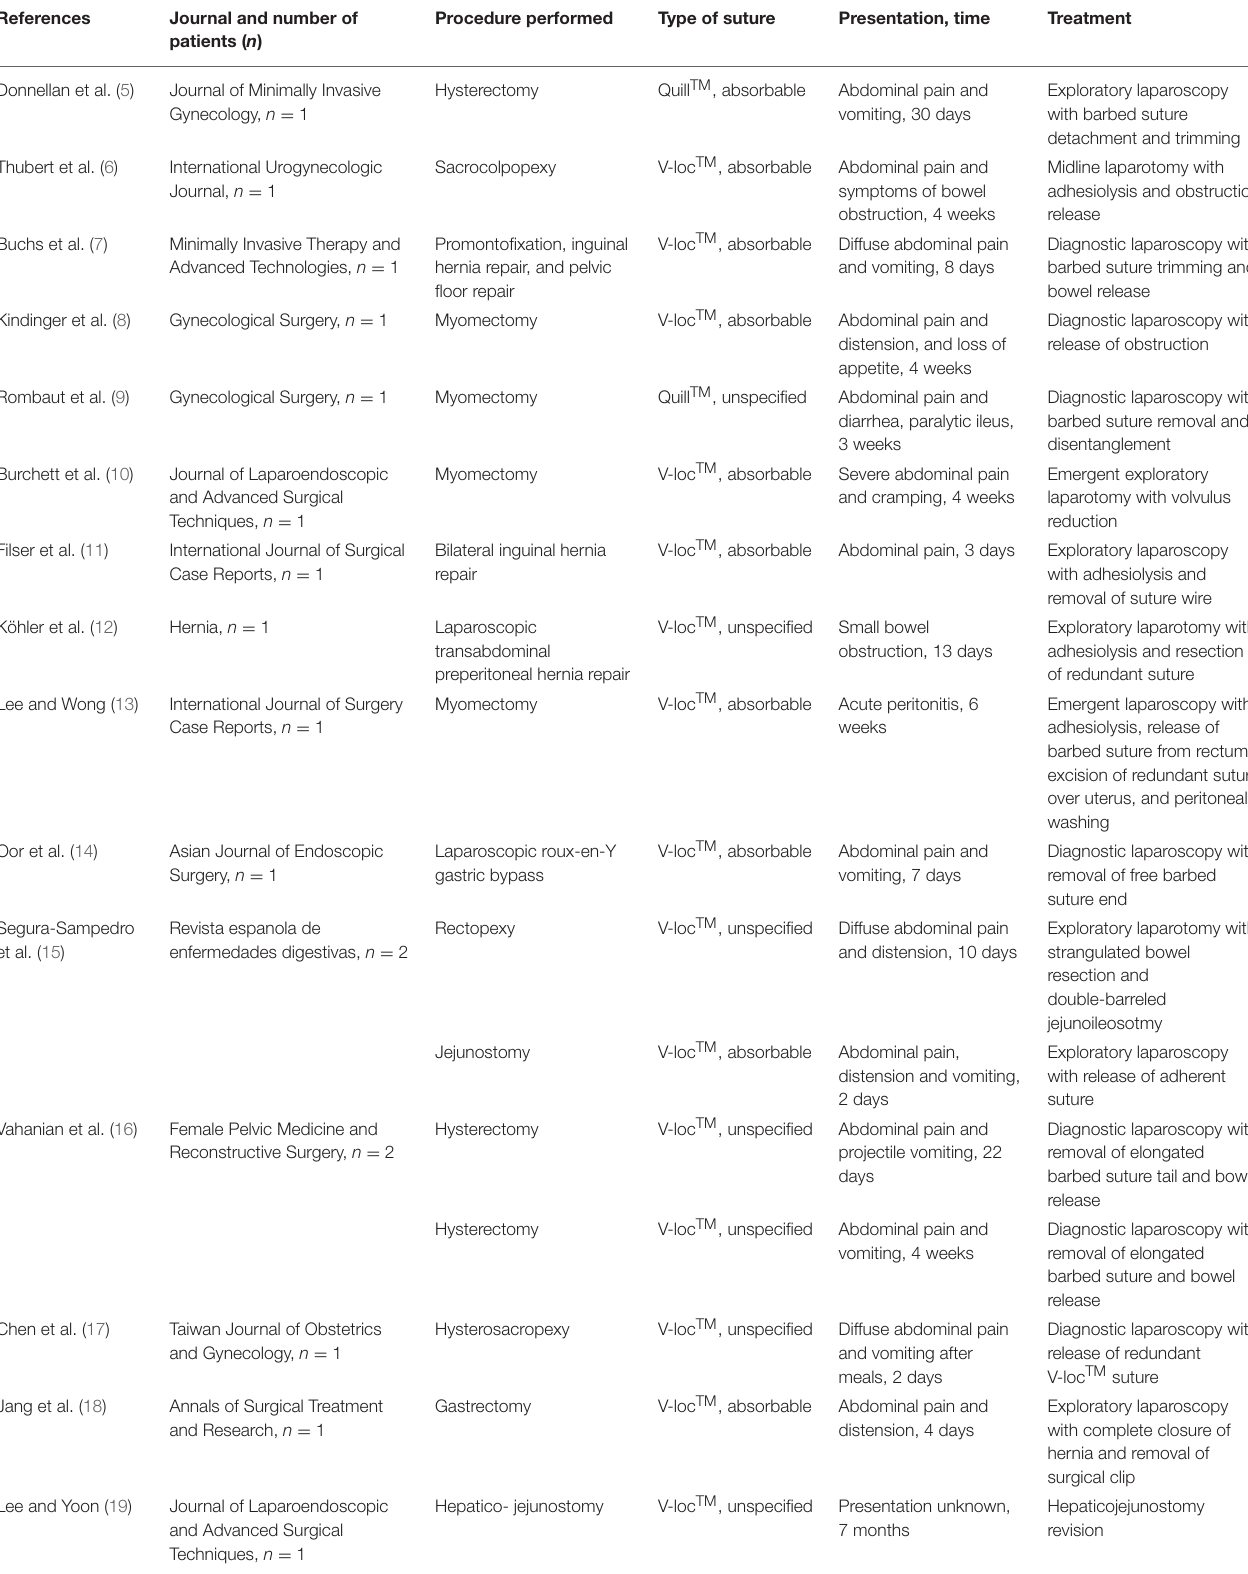
TABLE 3 | Review of the